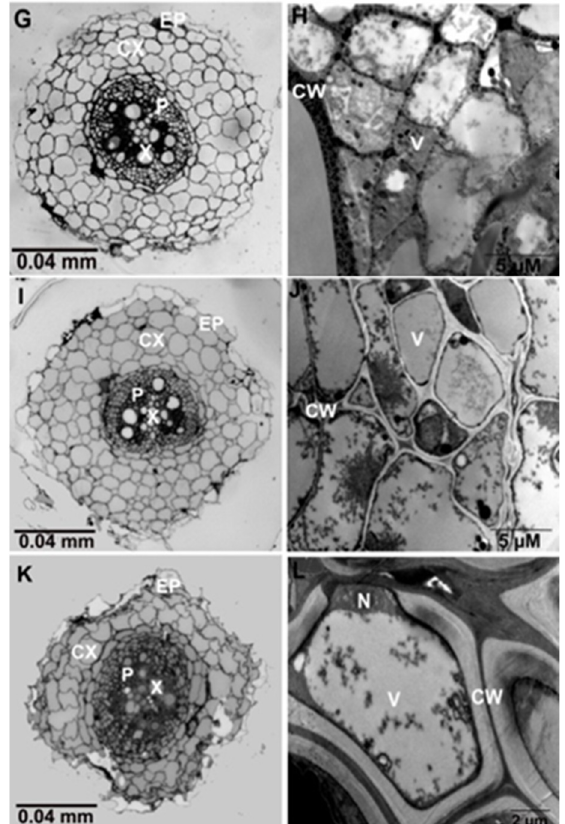
Figure 5. Thick and thin root sections of Solanum melongena control and NaCl-treated plants. Light microscopy micrographs of control plant ( A ); NaCl-treated plants with 25–100 mM ( C , E , G , I ) did